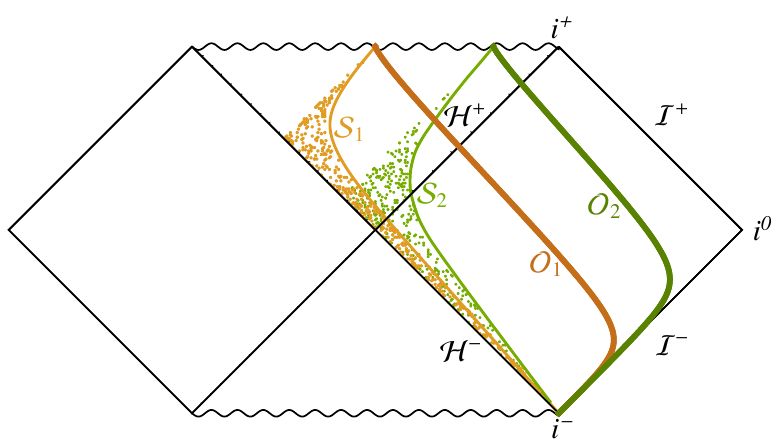
Figure 7. The stretched horizon S i demarcates the region within which communication with the late observer O requires sending super-Planckian signals. As O falls into the black hole along the i i blue trajectory, the stretched horizon S recedes. The classical space-time region outside of S acts i i as its own physical measurement apparatus through which observer O determines the value of the i soft hair mode f